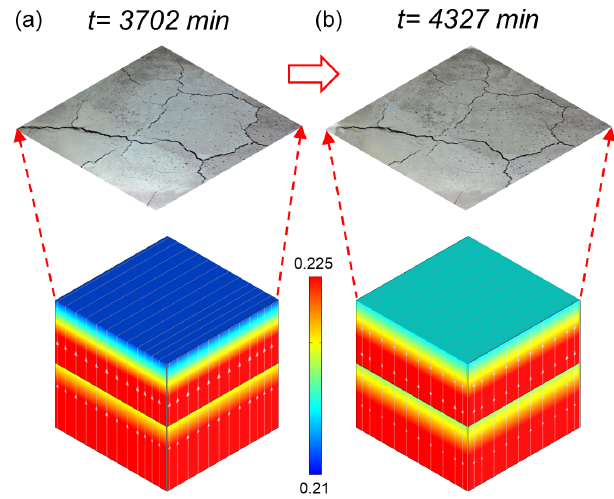
Figure 16. Crack images at t = 3702 and 4327min (photo at the top of the panels) as well as the vertical distribution of water con- tent in the numerical model (lower part of the panels) during the low-evaporation process. Panel (a) shows the beginning of the final low-evaporation stage during the first drying periods, while panel (b) shows the end of the final low-evaporation stage during the first drying